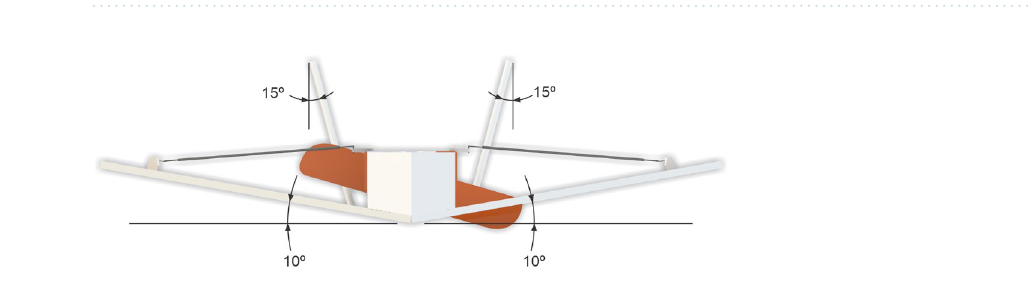
Figure 13. MicroBrosh conceptual project in top profile view.